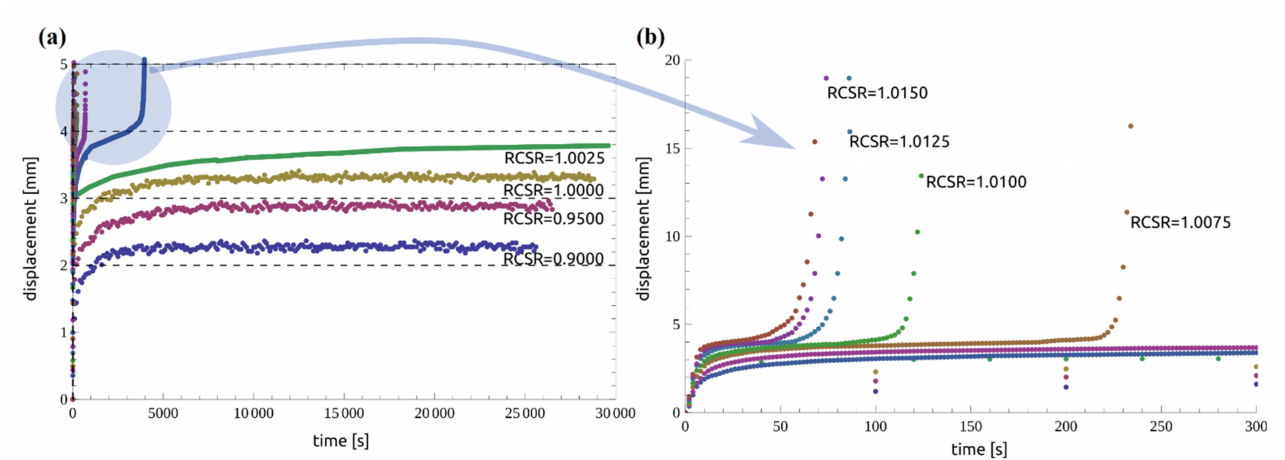
Figure 5. Summary of creep tests for RCSR up to 1.0150: ( a ) complete time range of 0–30,000 s; ( b ) initial time of experiment of 0–300